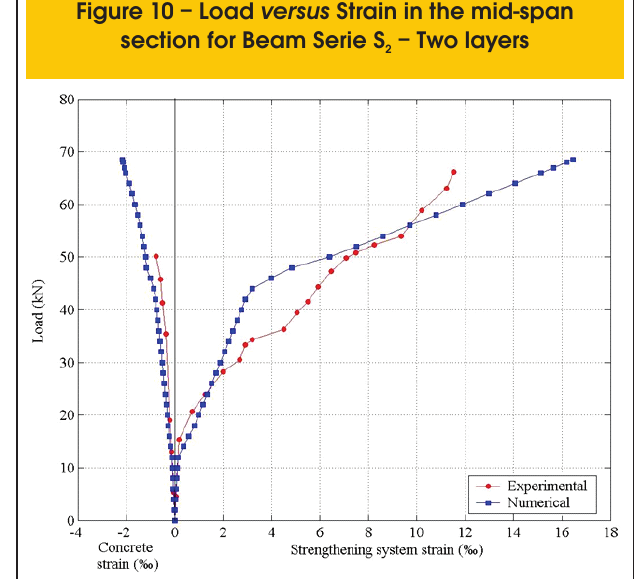
Figure 8 – Load versus Strain in the mid-span section for Beam Serie S – One layer 2